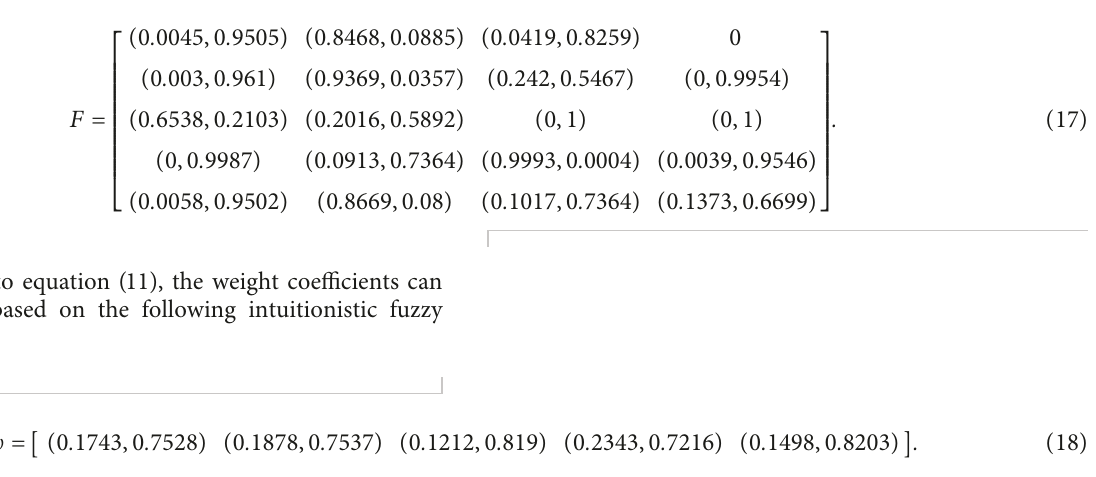
Figure 6: Membership function of the rockburst intensity: (a) uniaxial compressive strength σ shear stress and uniaxial compressive strength σ θ / σ c , (d) elastic strain energy index of rocks W et , and (e) integrity coefficients of the rock K mass v ) (